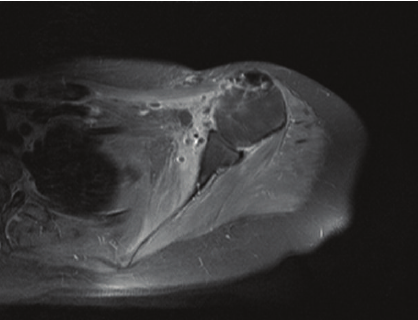
Figure 4: Postoperative MRI showing the anterior shoulder recon- struction with viable pedicle flap of pectoralis